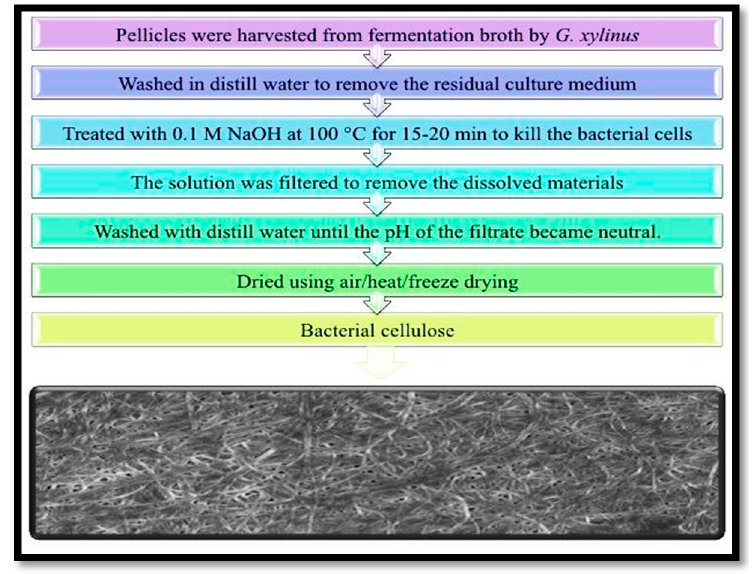
Figure 3. The process of purification of bacteria cellulose (BC) from G. xylinus .